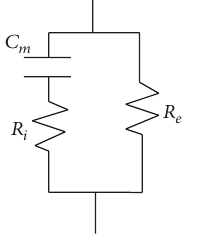
Figure 1: Fricke